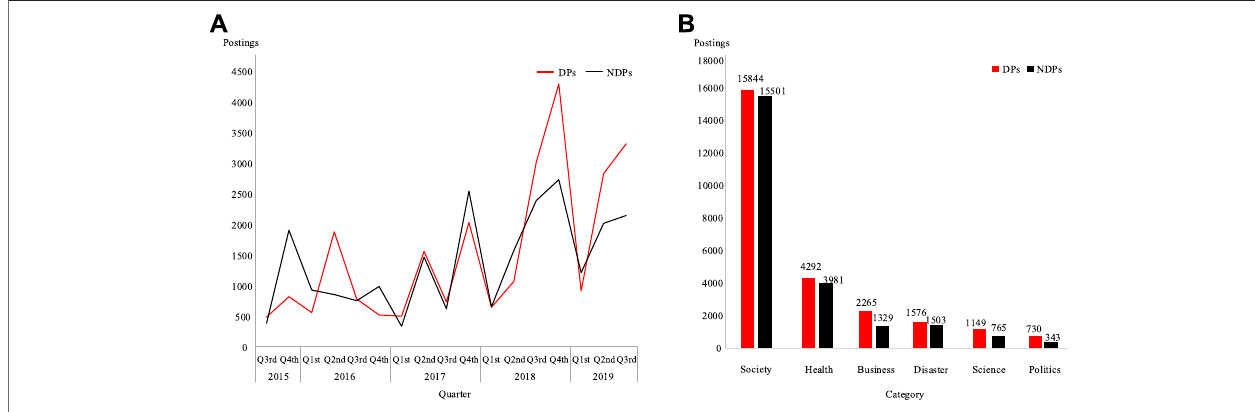
FIGURE 2 | Descriptive analysis of DPs and NDPs: (A) quarterly DPs and NDPs and (B) the number of DPs and NDPs under the six fake news topics. Notes: Science represents science and technology and Politics denotes politics and fi